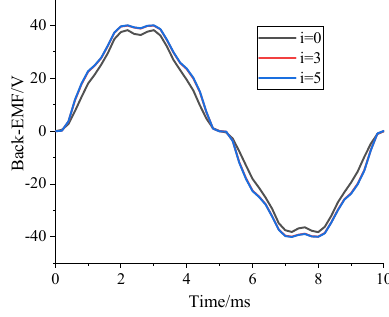
Figure 21. Waveform of back EMF.